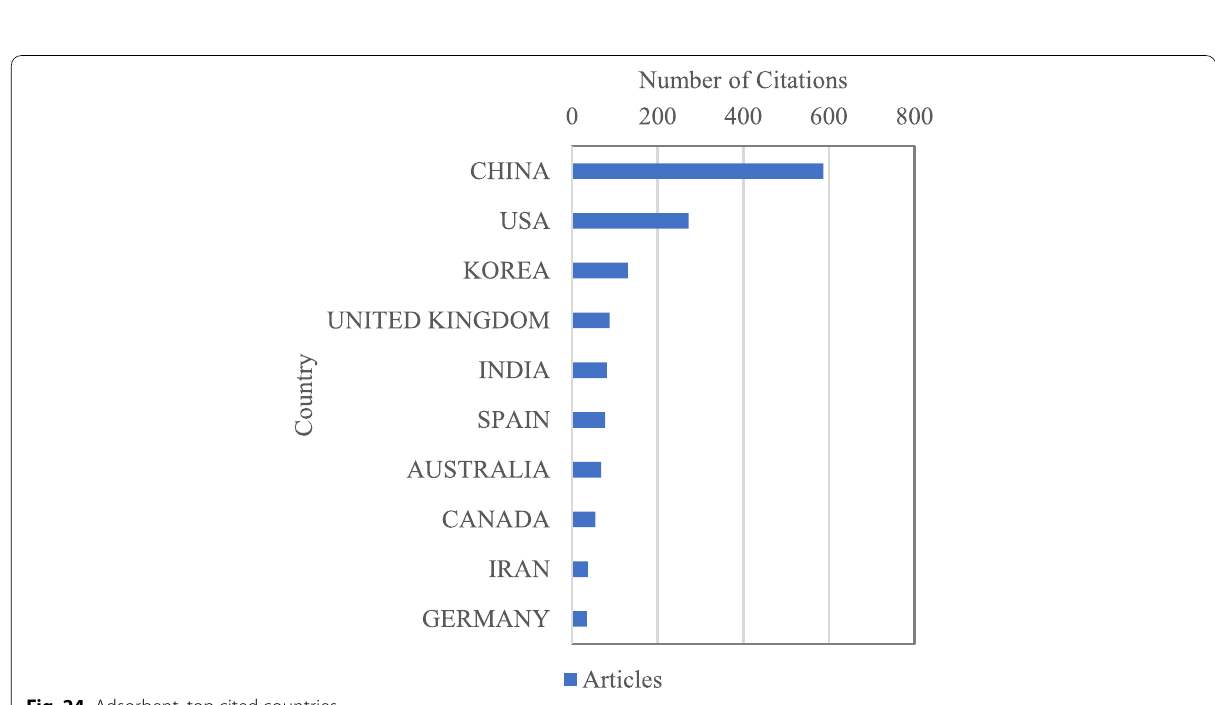
Fig. 24 Adsorbent, top cited